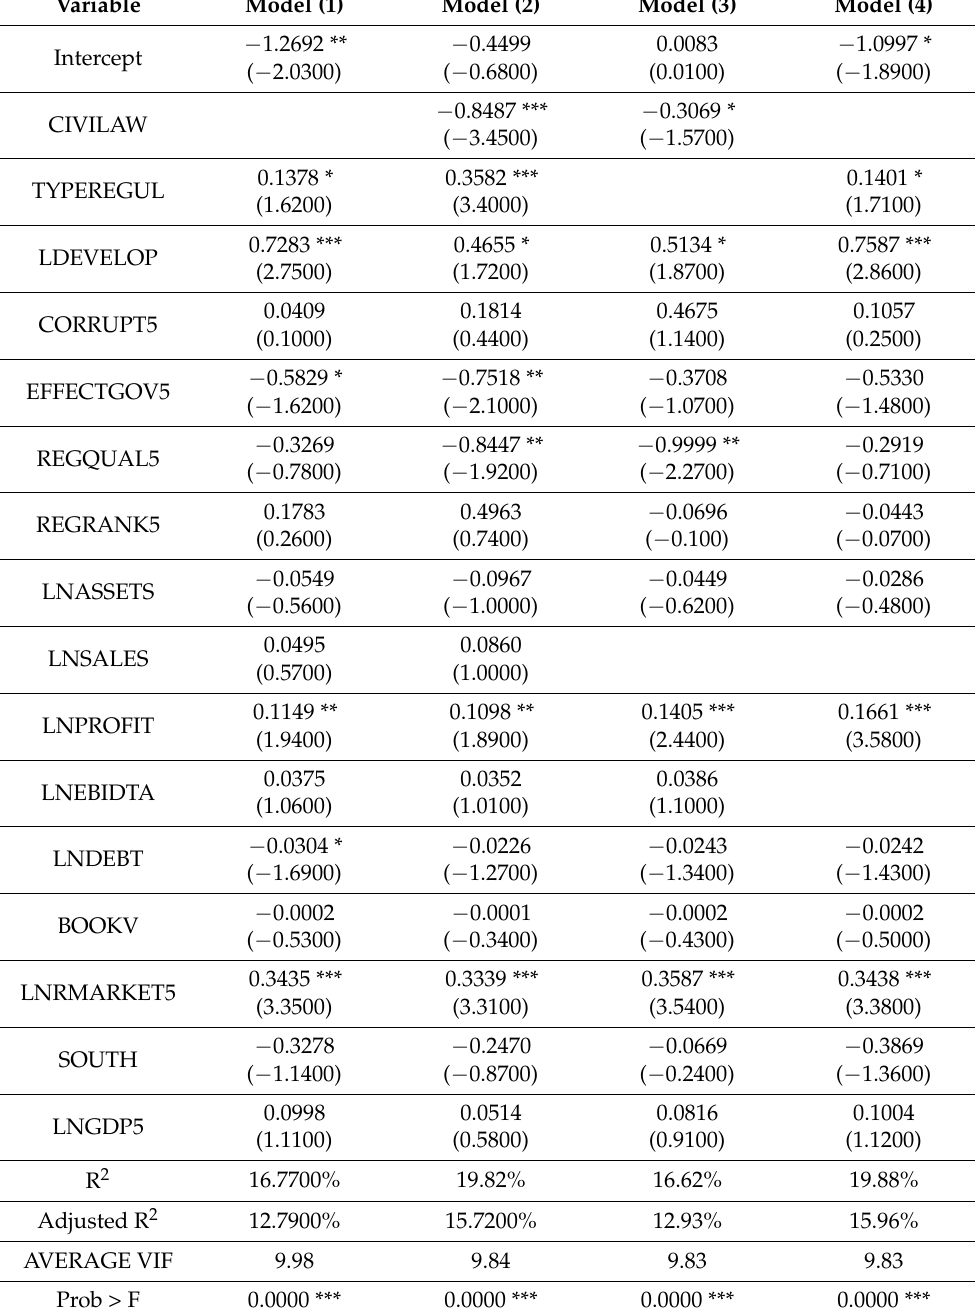
Table 8. Five-year return—LNBHR5—results